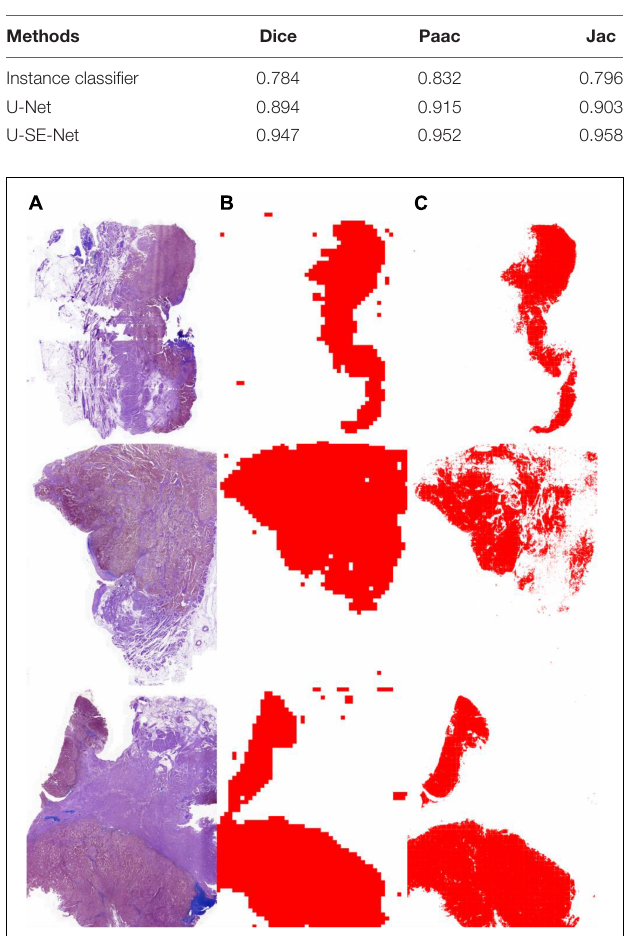
TABLE 3 | The tumor segmentation performance of the instance classifier, U-Net, and U-SE-Net. Methods